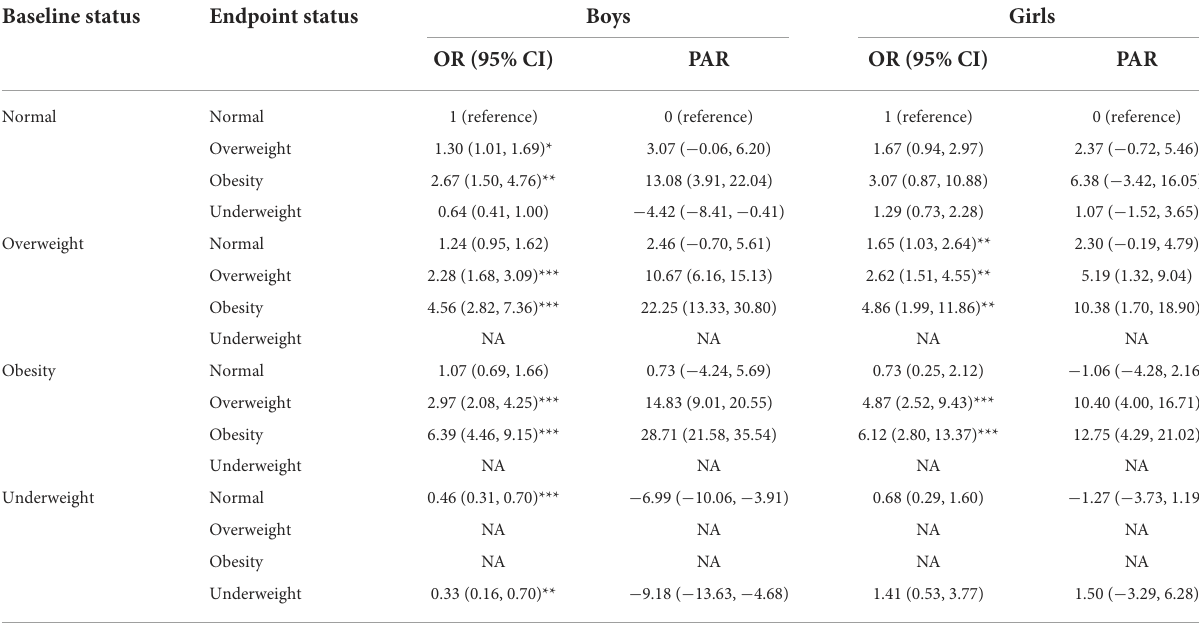
TABLE 4 Risk and populational attributable risk of high blood pressure at late adolescent from children of different weight status. Baseline status